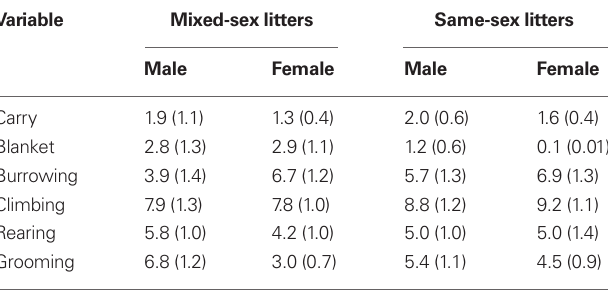
Table 2 | Mean ( ± SEM) total frequencies of each behavior across 10-min sessions conducted on